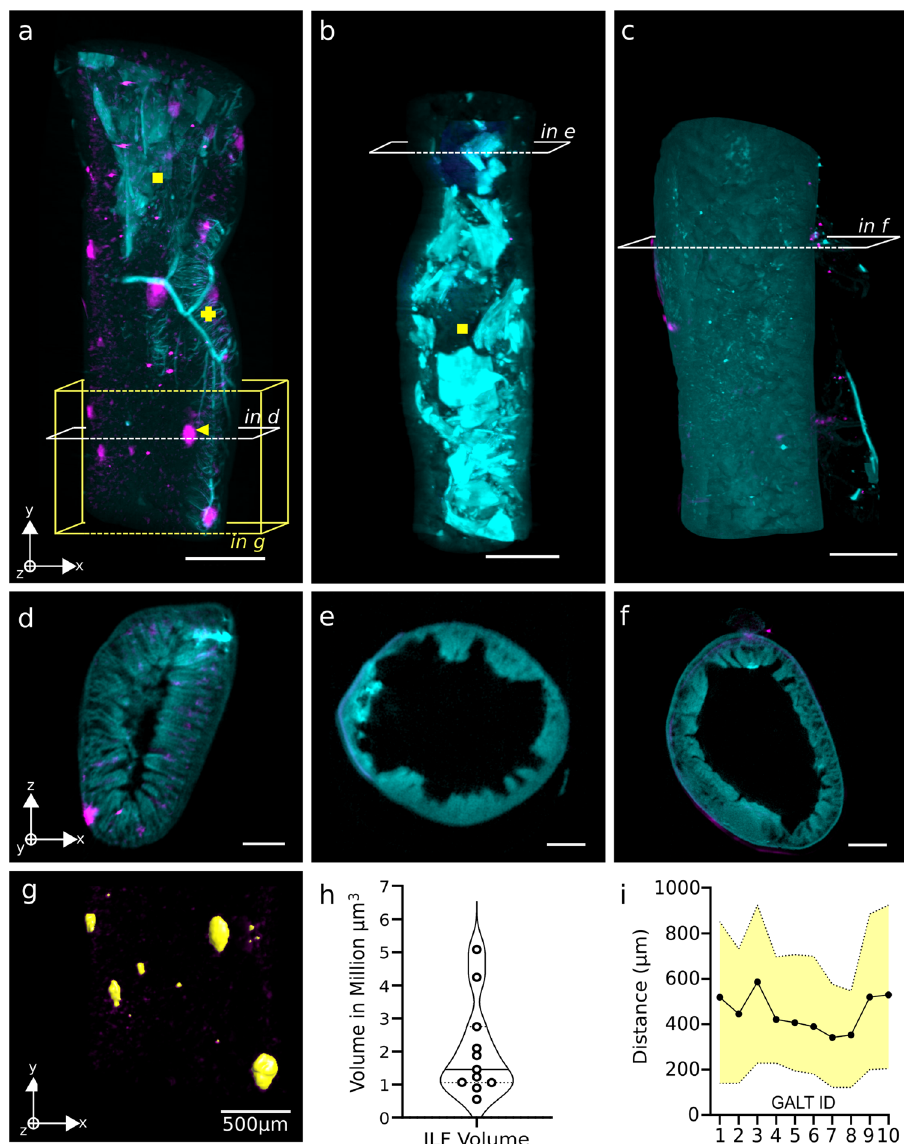
Fig. 3 Multi-channel OPT reconstructions and segmentation of gut immune compartment. a – c Longitudinal views of two-channel OPT renders with tissue auto fl uorescence in cyan and CD45-positive cell clusters in magenta. Age- and microbiota-dependent development of gut-associated lymphoid tissues (GALTs) is evident in a healthy adult SPF gut ( a ) versus adolescent SPF ( b ) and adult germ-free ( c ) gut samples. Structures of interest include the positive cell clusters (arrow), vascular network (cross) and luminal dietary fi bers (square). Scale bars represent 1000 μ m. d – f Cross-sectional view of 3D reconstructions for the samples shown ( a – c ). Scale bars represent 200 μ m. g 3D segmentation of signal from isolated lymphoid follicles (ILFs) observed in box shown in a . h Violin plot of measured volume of individual CD45-positive regions in an adult C57BL/6J mouse, measured in million- μ m 3 . i Spatial distribution of ILFs throughout the tissue seen in a as measured by minimum, mean and maximum distance in μ m between each